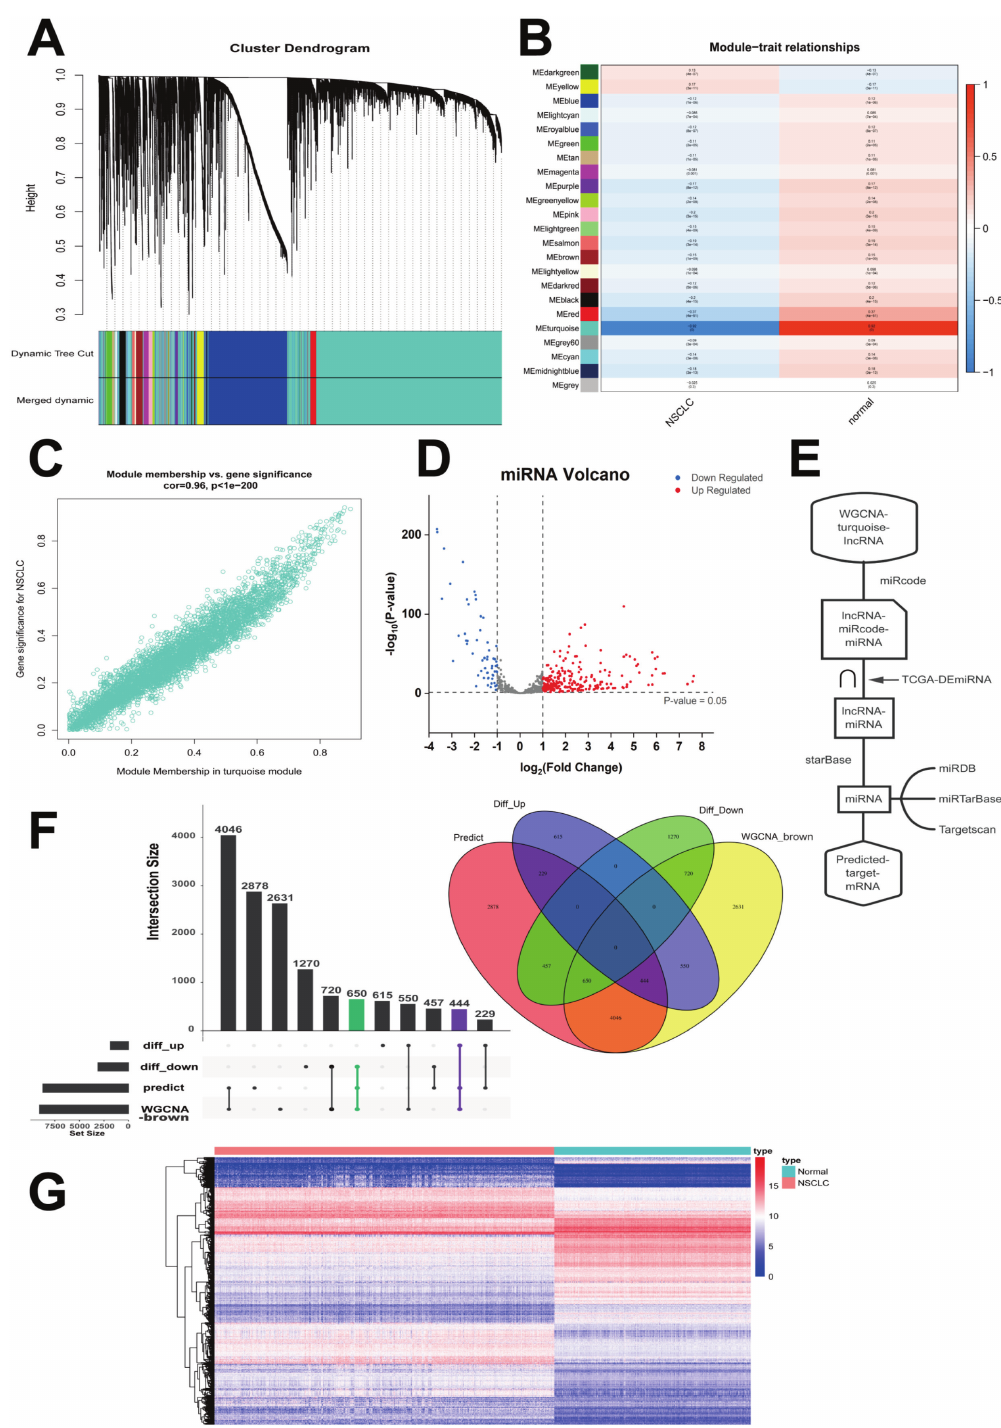
Fig 4. Analysis of lncRNA modules by WGCNA and prediction of target genes. (A) Cluster dendrogram of lncRNAs with top 60% variances clustered based on topological overlap. (B) Correlation of lncRNA modules between NSCLC and normal samples. The ME of the turquoise module was the most positively related to traits. (C) Relationship between gene significance and module membership in the turquoise module. (D) Volcano map of 316 DEmiRNAs (|logFC| > 1, P < 0.05) in NSCLC. (E) Flow chart of target mRNA prediction. (F) Overlapped target mRNAs were analyzed by the predicted target mRNAs, WGCNA-brown mRNAs, and the significantly up- or down-regulated mRNAs. (G) Expression heatmap displaying the 1094 predicted target mRNAs in NSCLC. WGCNA, weighted gene co-expression network analysis; NSCLC, non-small cell lung cancer; ME, module eigengene.